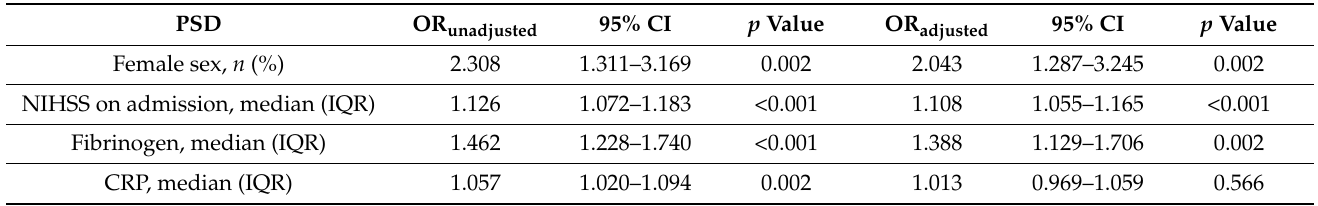
Table 2. Univariate and multivariate analysis of clinical characteristics in patients with or with- out PSD.